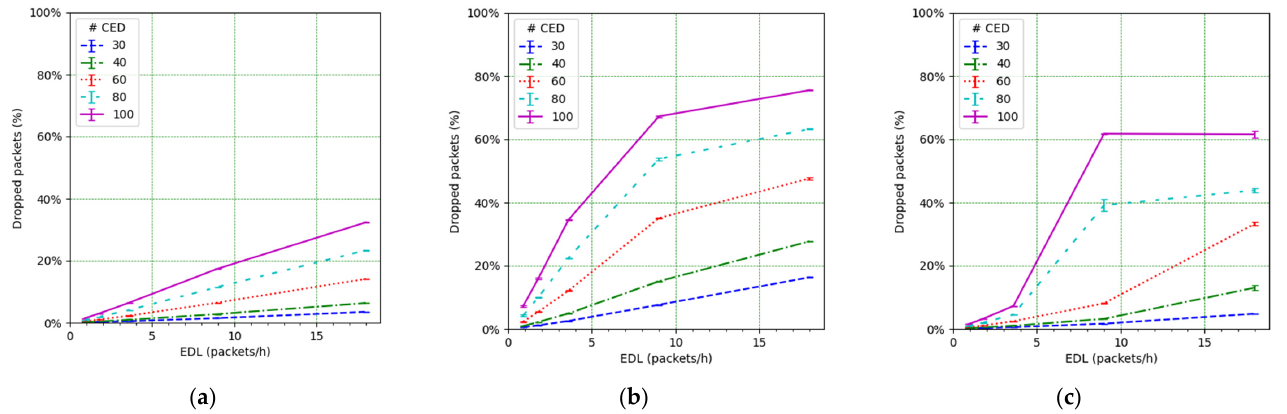
Figure 17. Packet losses due to duty cycle at the gateway vs. EDL for ( a ) SFM1, ( b ) SFM2, and ( c ) SFM3.